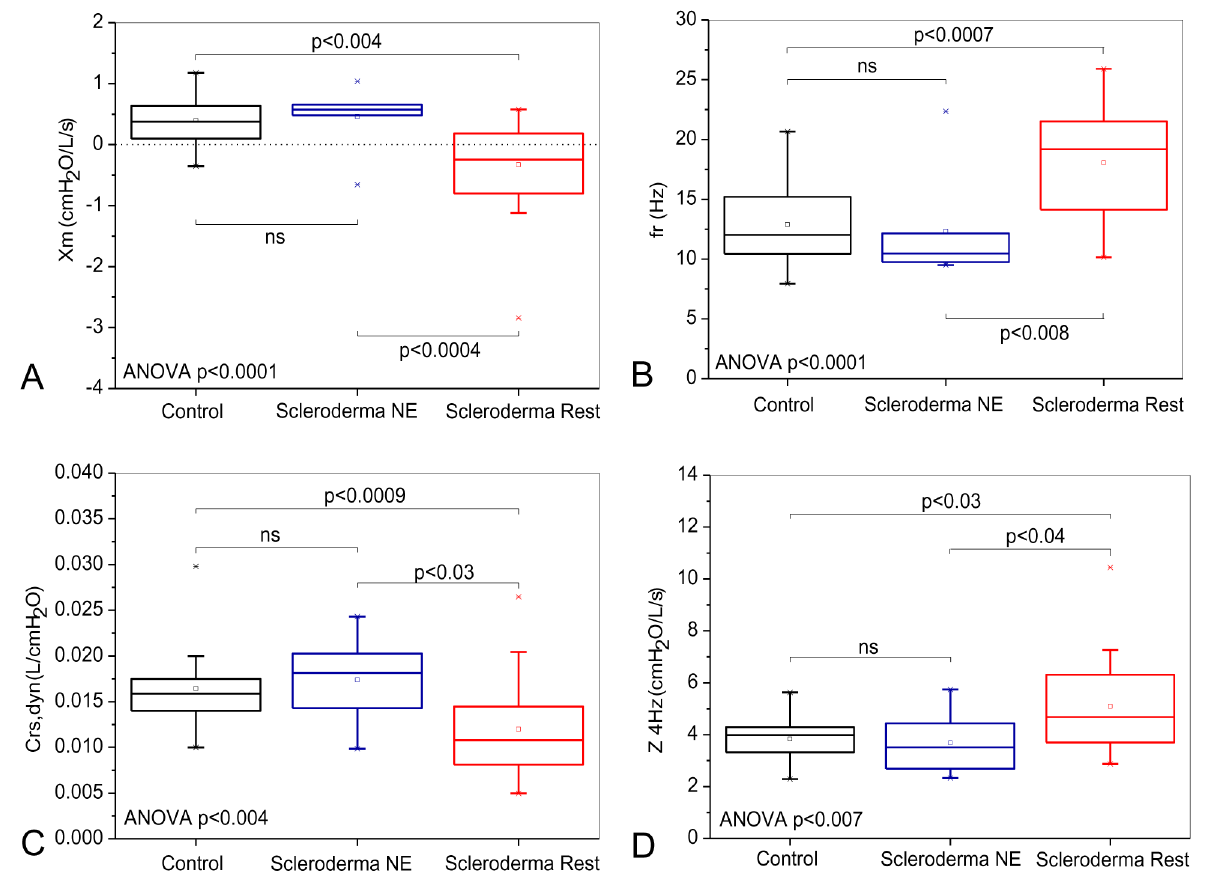
Figure 6. Influence of the restricted pattern in the lung volume tests on the reactive properties of the respiratory system. The mean reactance (Xm; Figure A) and the dynamic compliance of the respiratory system (Crs,dyn; Figure B) decreased, whereas the resonant frequency (fr; Figure C) and the impedance modulus at 4 Hz (Z4Hz; Figure D) exhibited a significant increase.